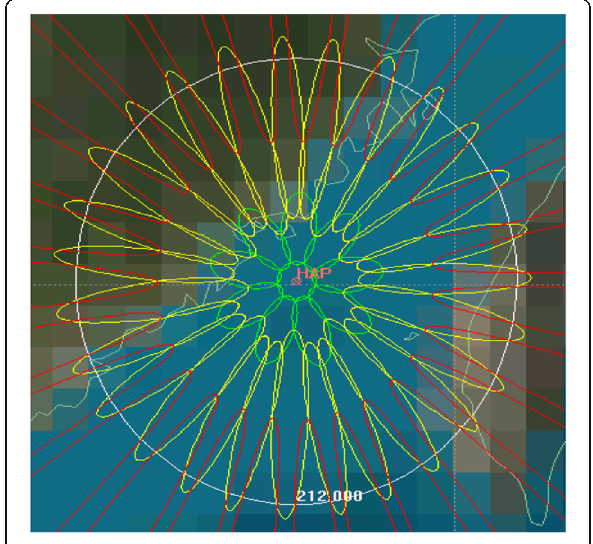
Fig. 8 Schematic diagram of a two-platform four-layer ring cell waveform with a single platform at 5° elevation angle (55